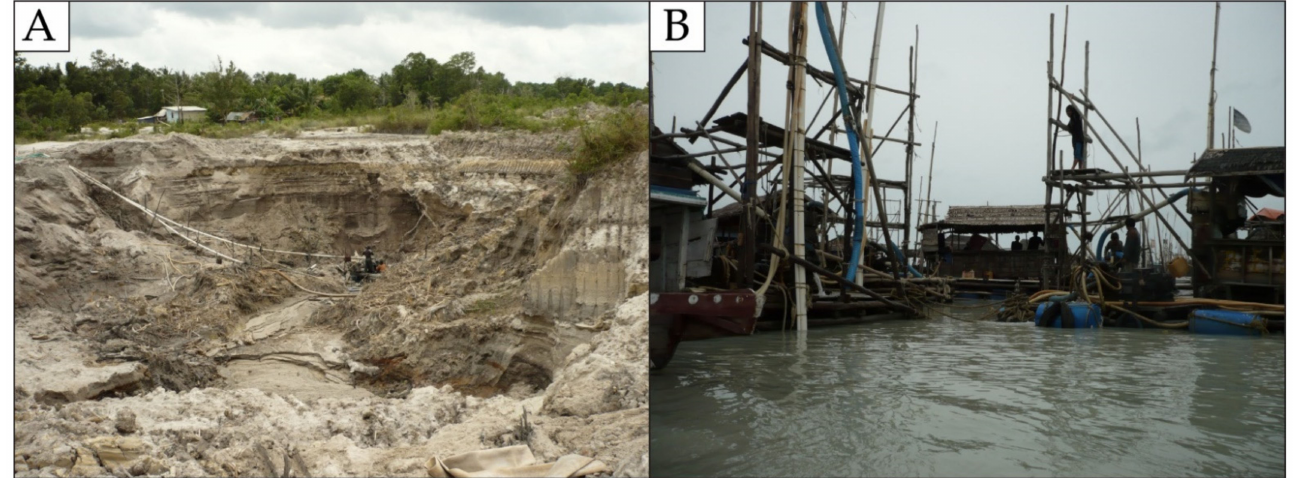
Figure 2. Mining on Bangka Island: ( A ) open-pit cassiterite mining; ( B ) marine cassiterite extraction using primitive mining platforms.